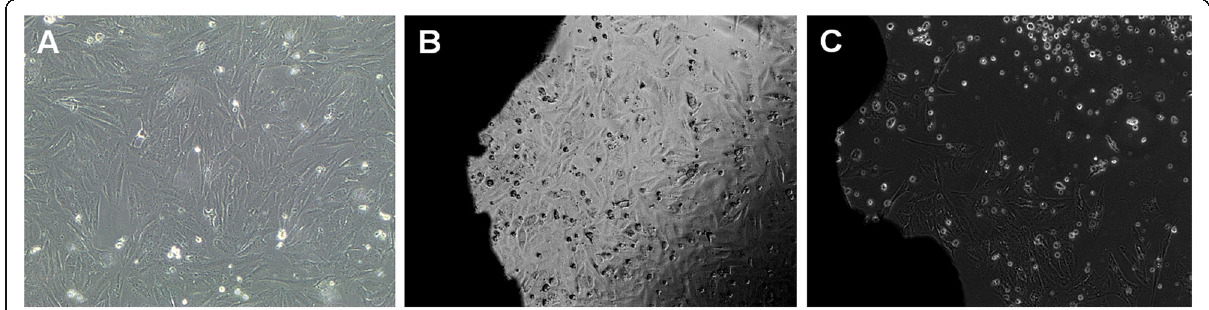
Fig. 3 Human primary osteogenic sarcoma (Saos-2) cells (5 × 10 4 cells). a Saos-2 cells before plating; b 24 h of Saos-2 cells on dental implant surface; c 72 h of Saos-2 cells on dental implant